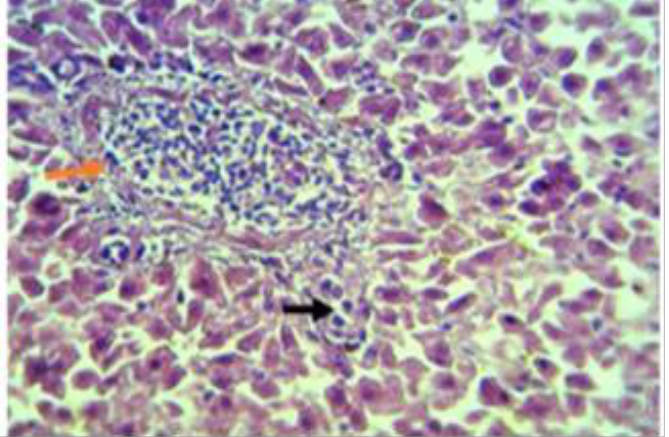
Figure 16. Histopathological section of liver of chicken shows congestion and thickening in blood vessel wall with inflammatory cells inside their lumen ( ) and between the hepatocyte ( ) (H&E, 400X)